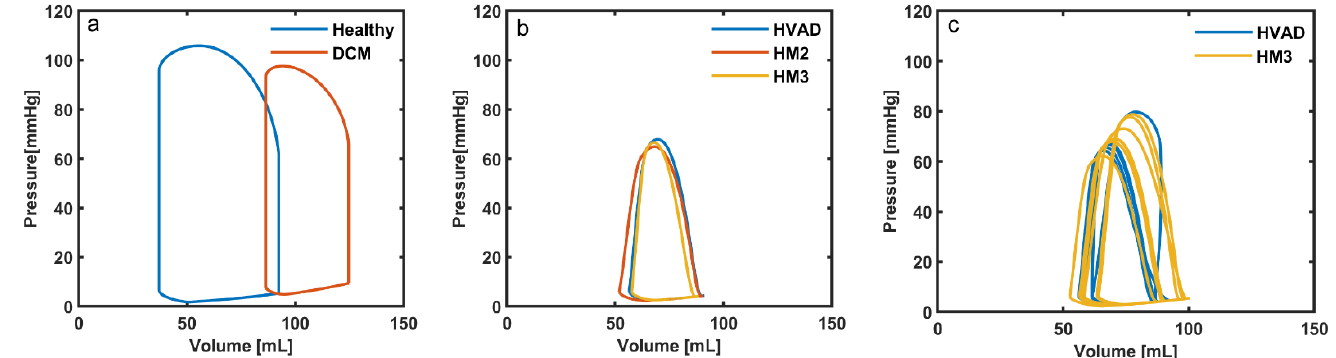
Figure 5. ( a ) Left-ventricular pressure – volume loops in the healthy and DCM cardiovascular system models, ( b ) left-ventricular pressure – volume loops under HVAD, HM2 and HM3 support, ( c ) left- ventricular pressure – volume loops under HVAD and HM3 support during the Lavare cycle and artificial pulse. Table 2. Haemodynamic variables in the healthy and DCM cardiovascular system models and under HVAD, HM2 and HM3 support. MAP, mean arterial pressure; PP, pulse pressure in aorta; CO, cardiac output; MPO: mean pump output; EDV, end-diastolic volume; ESV, end-systolic volume; EDD, end-diastolic diameter; ESD, end-systolic diameter. * indicates maximal values for PP, EDV and EDD whilst indicating minimal values for ESV and